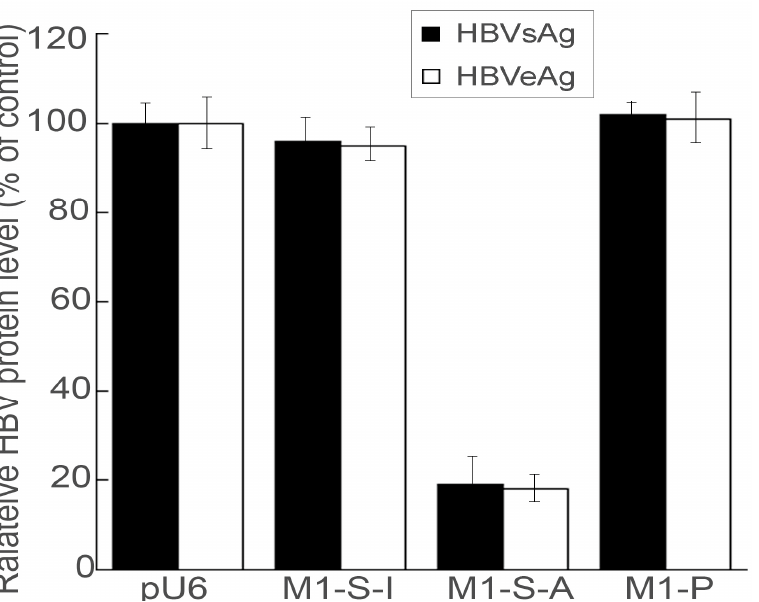
Figure 4. Inhibition of HBV protein expression in HepG2.2.15 cells expressing RNase P ribozyme. Media were collected from the cultures of ribozyme-expressing cells and ELISA was used to assay the HBsAg and HBeAg levels. The values, which are the average of triplicate experiments, represent the relative percentage of the levels of HBsAg and HBeAg in cells with different ribozymes, as compared to those in cells with empty vector pU6. The error bars show the standard deviation.